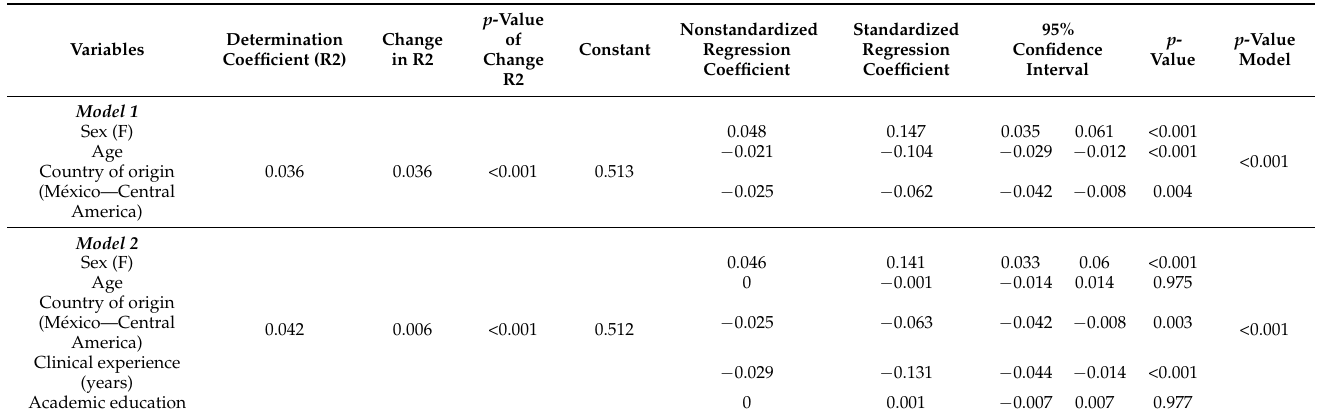
Table 6. Multiple linear regression model of collateral effects in dentists. (n =